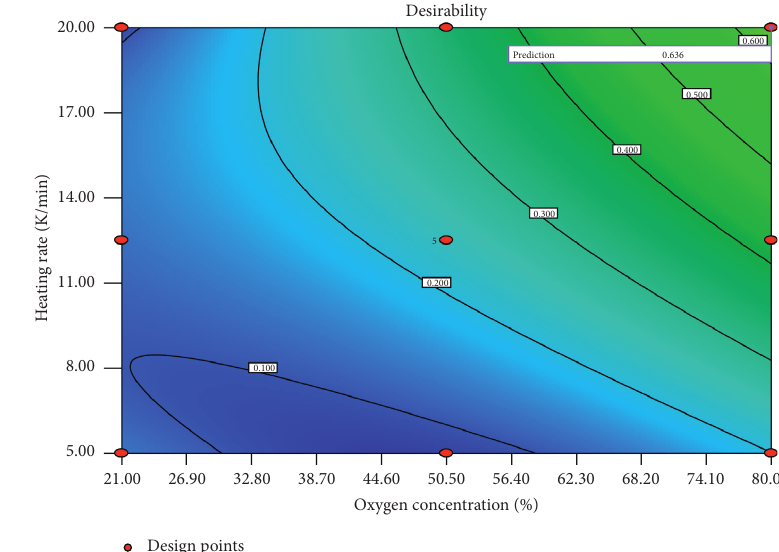
Figure 8: Expected response surface map between desirability of oxygen concentration and heating rate using optimization scheme